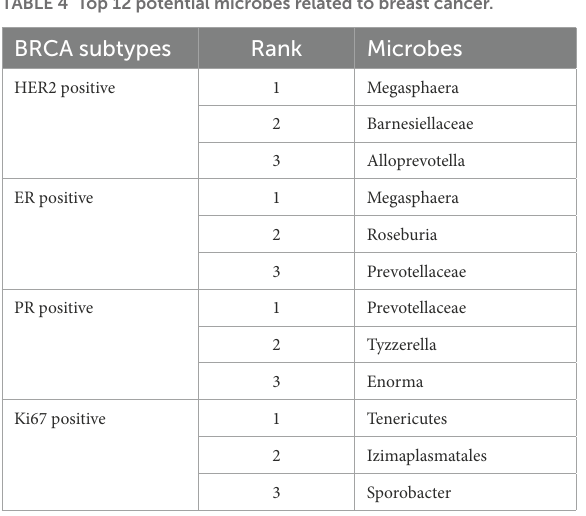
Bold values represent the effect of our model.